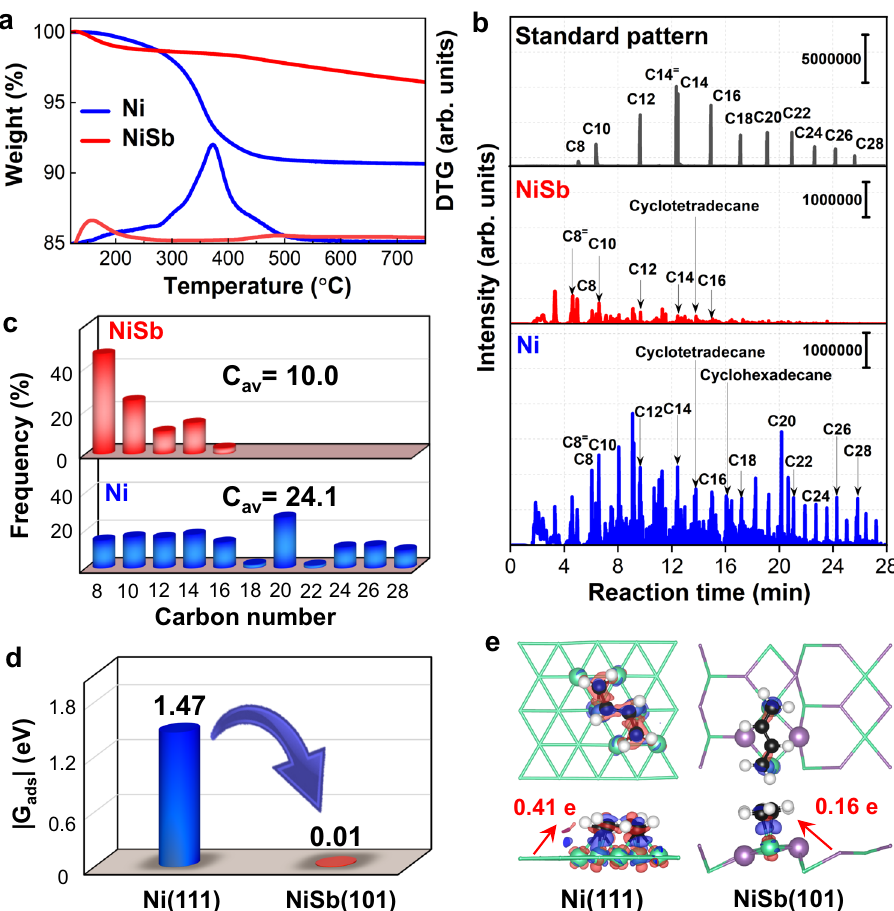
Fig. 6 | Coke analysis. a TG-DTG pro fi les of the spent Ni and NiSb catalysts. b PyrolysisGC-MSpro fi lesofgreenoildepositedontheNiandNiSbcatalystswhere thestandardpatternistakenfromtherefs.41,47and c correspondingstatisticsfor carbon numbersof hydrocarbons contained ingreen oil. d Adsorption-free energy of 1,3-butadiene over the Ni(111) and NiSb(101) surfaces. e Top and front views of